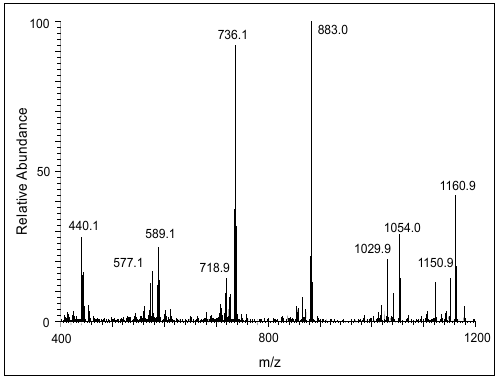
Figure 12. The CID mass spectrum of the ion with an m / z value of 1178 amu.